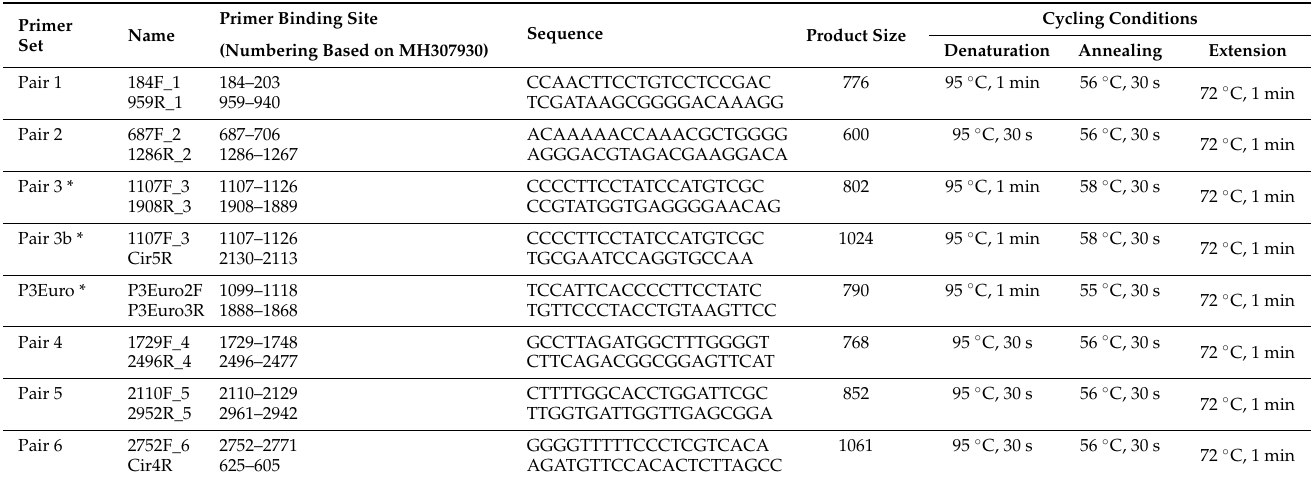
Table 1. Primer and cycling conditions used to obtain the full genomic sequence of domestic cat